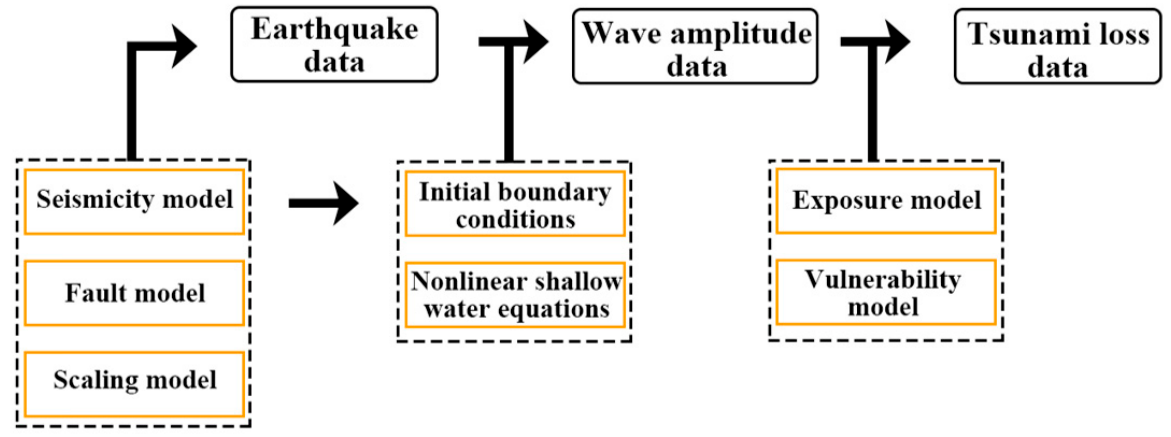
Figure 1. Flowchart for generating synthetic tsunami hazard and risk data.